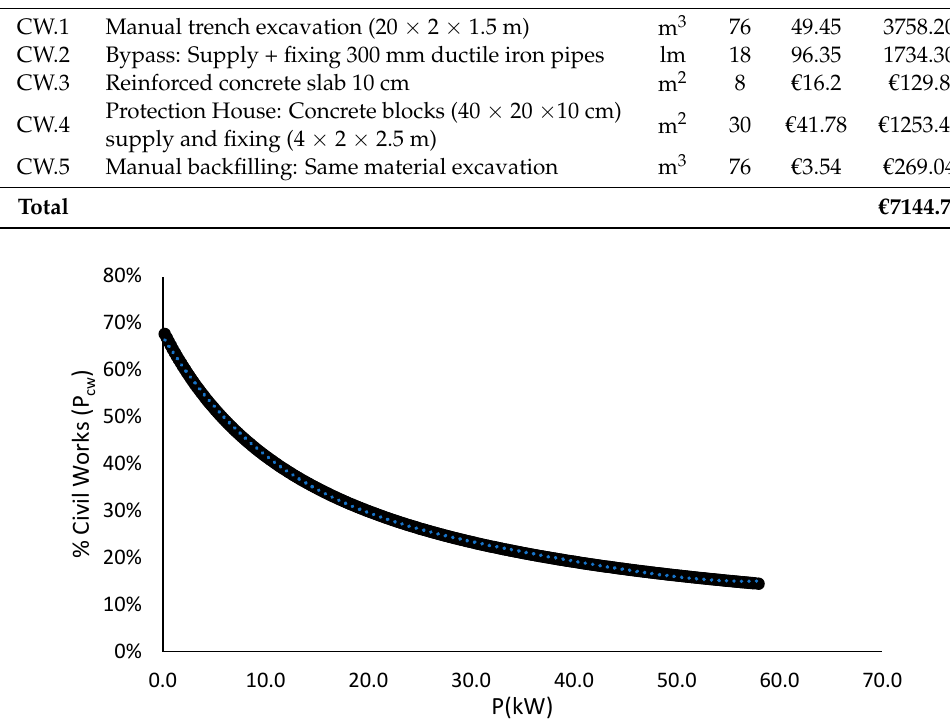
Figure A1. Cost percentage represented by the civil works depending on the PAT power.